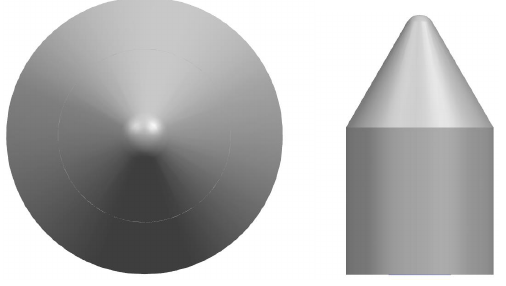
Figure 9. Original valve core (model